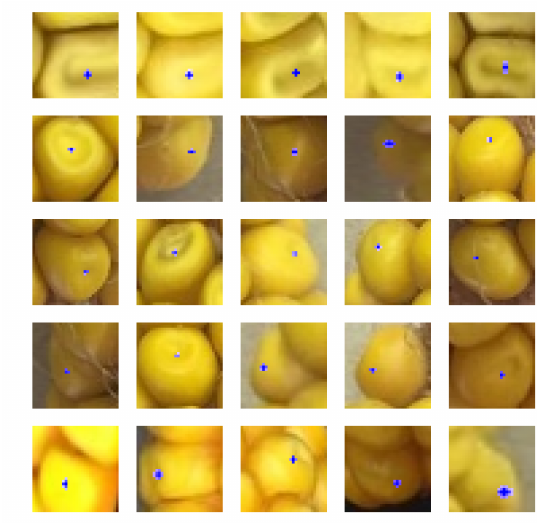
Figure 5. A random subset of annotated kernel images. The blue dot indicates the center of the kernel.